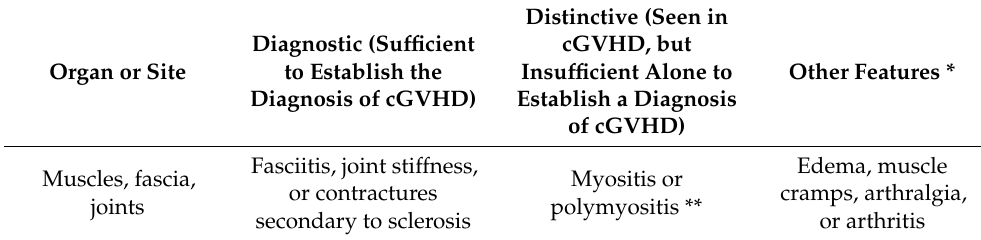
Other Features * Edema, muscle cramps,